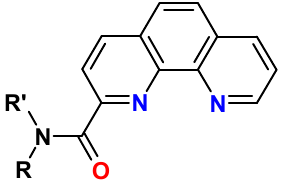
Figure 3. Amides of 1,10-phenanthroline-2-carboxylic acid (PTA).